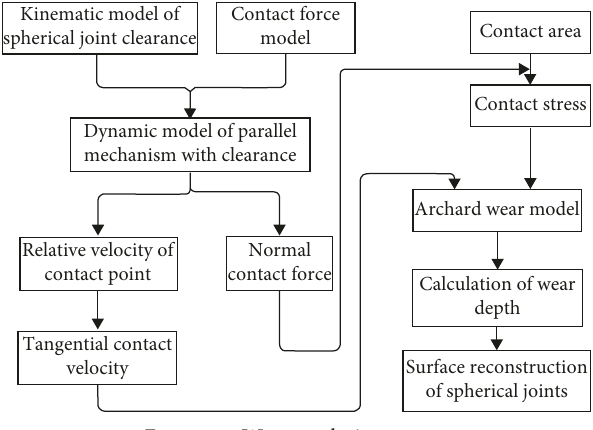
Figure 7: Wear analysis